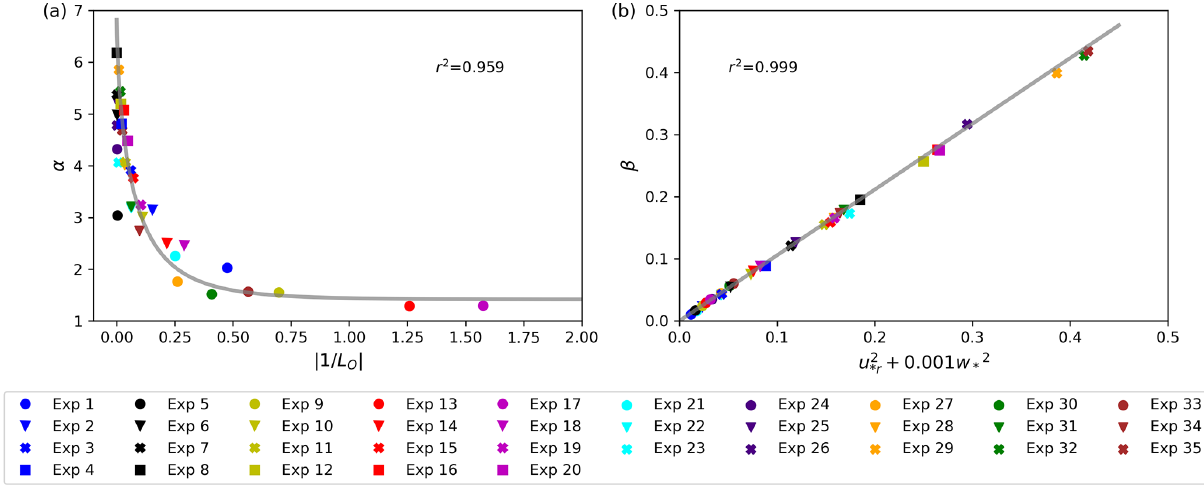
− 1 o for all numerical experiments Exp (1–35). (b) Dependency of scaling parameter